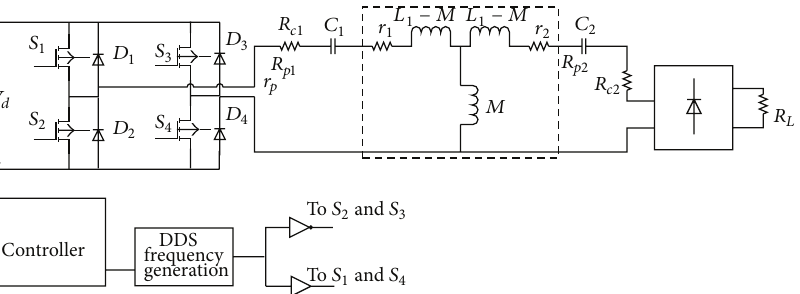
Figure 4: Diagram of the practical implementation.